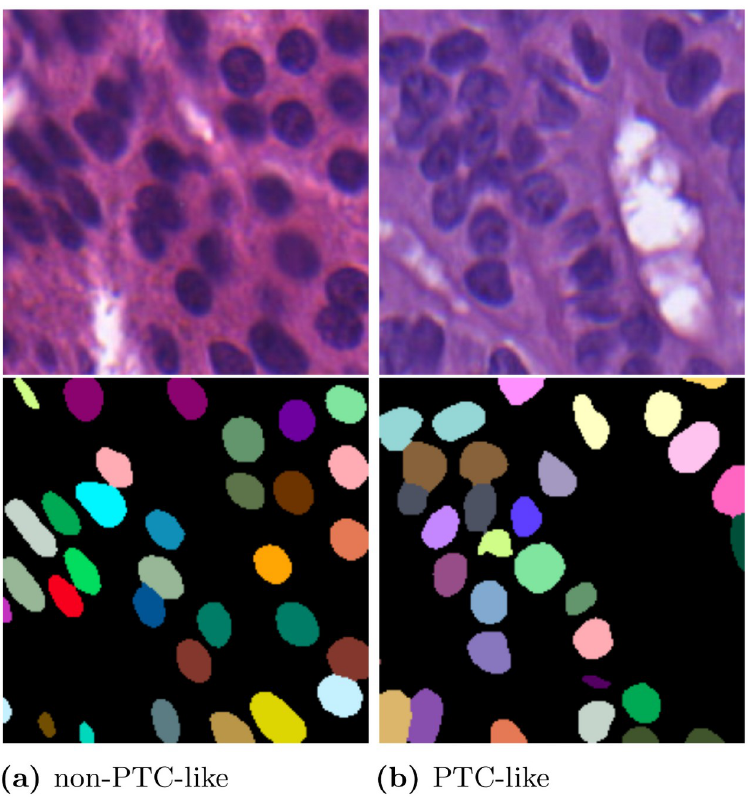
Fig 3. Exemplary thyroid images from the Tharun and Thompson dataset and the corresponding instance segmentations. The images are 200 × 200 px crops. The left images show a non-PTC-like sample and the right images a PTC-like